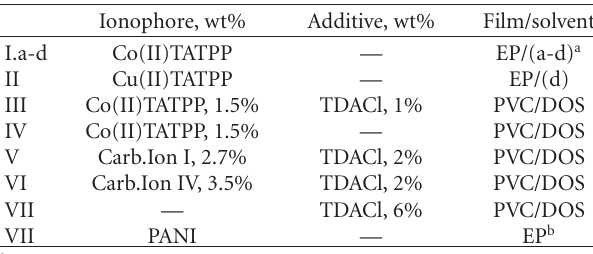
Table 1: Membrane compositions and deposition